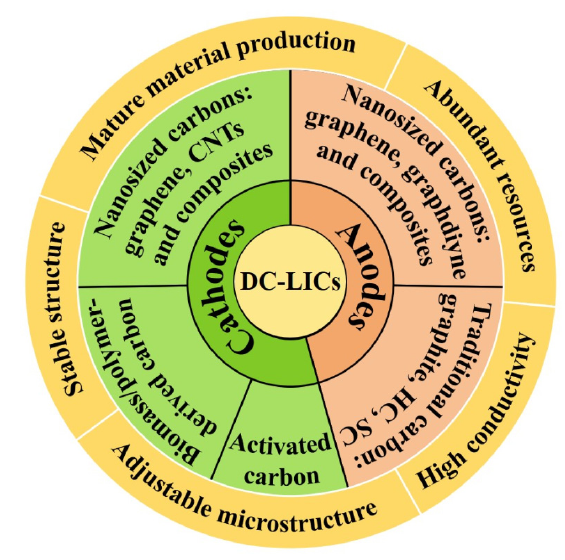
Figure 2. Typical carbon cathode and anode materials for DC-LICs.